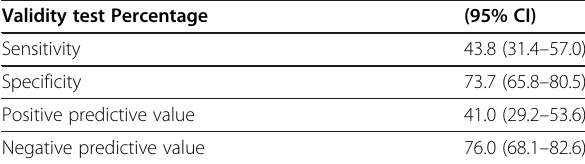
Table 3 Performance of RDW in the diagnosis of IDA among pregnant women at Khartoum